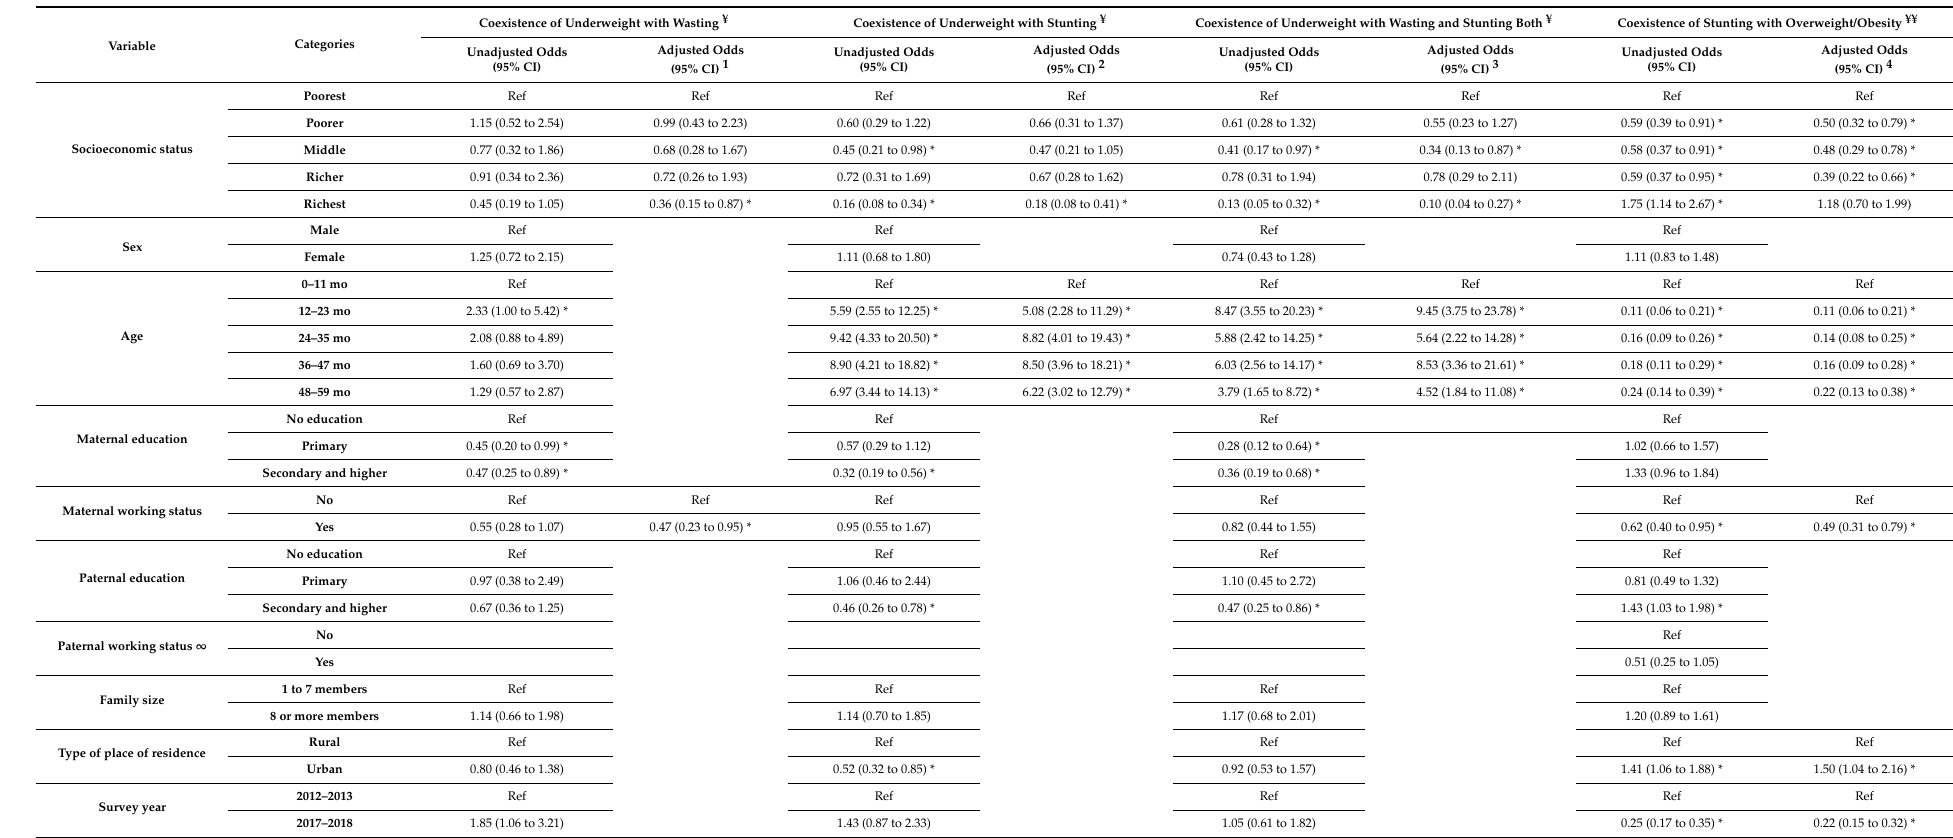
Table 4. Assessing the determinants of various types of coexisting forms of malnutrition in children under five years of